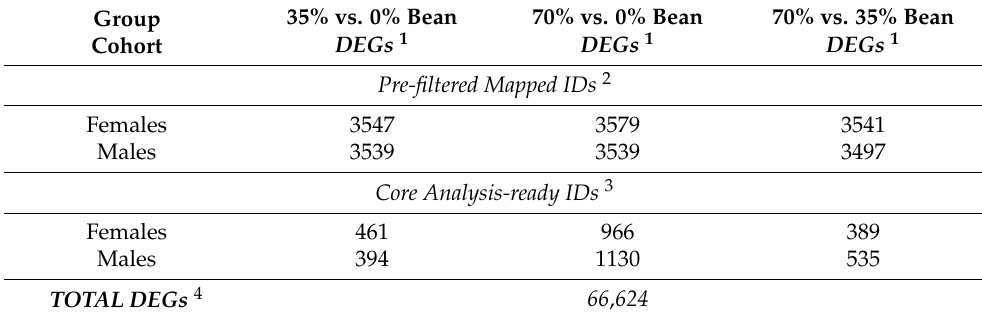
Table 1. IPA analysis-ready identifiers mapped to DEGs within each comparison group